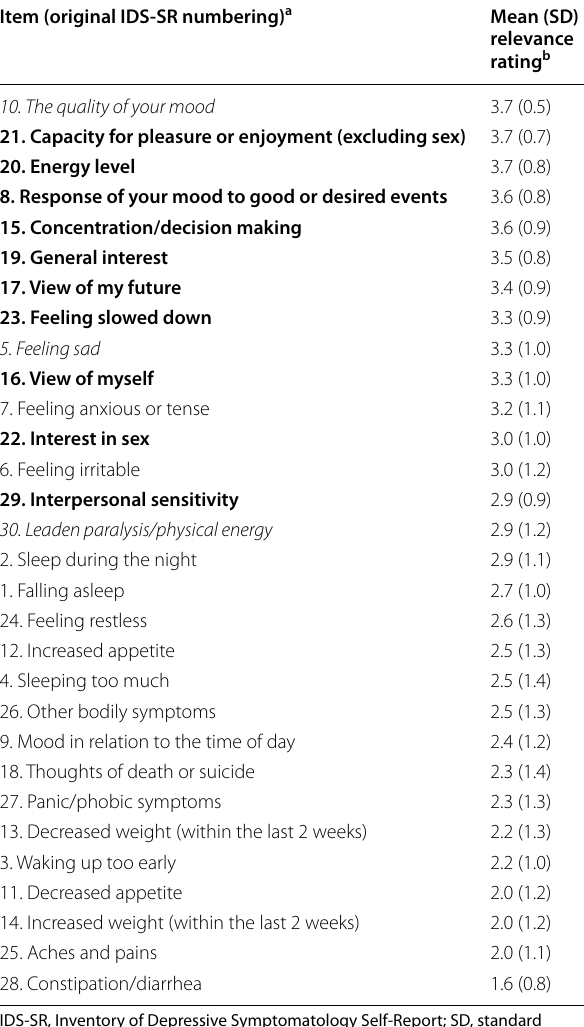
Table 3 Patient ratings of the relevance of IDS-SR items to life